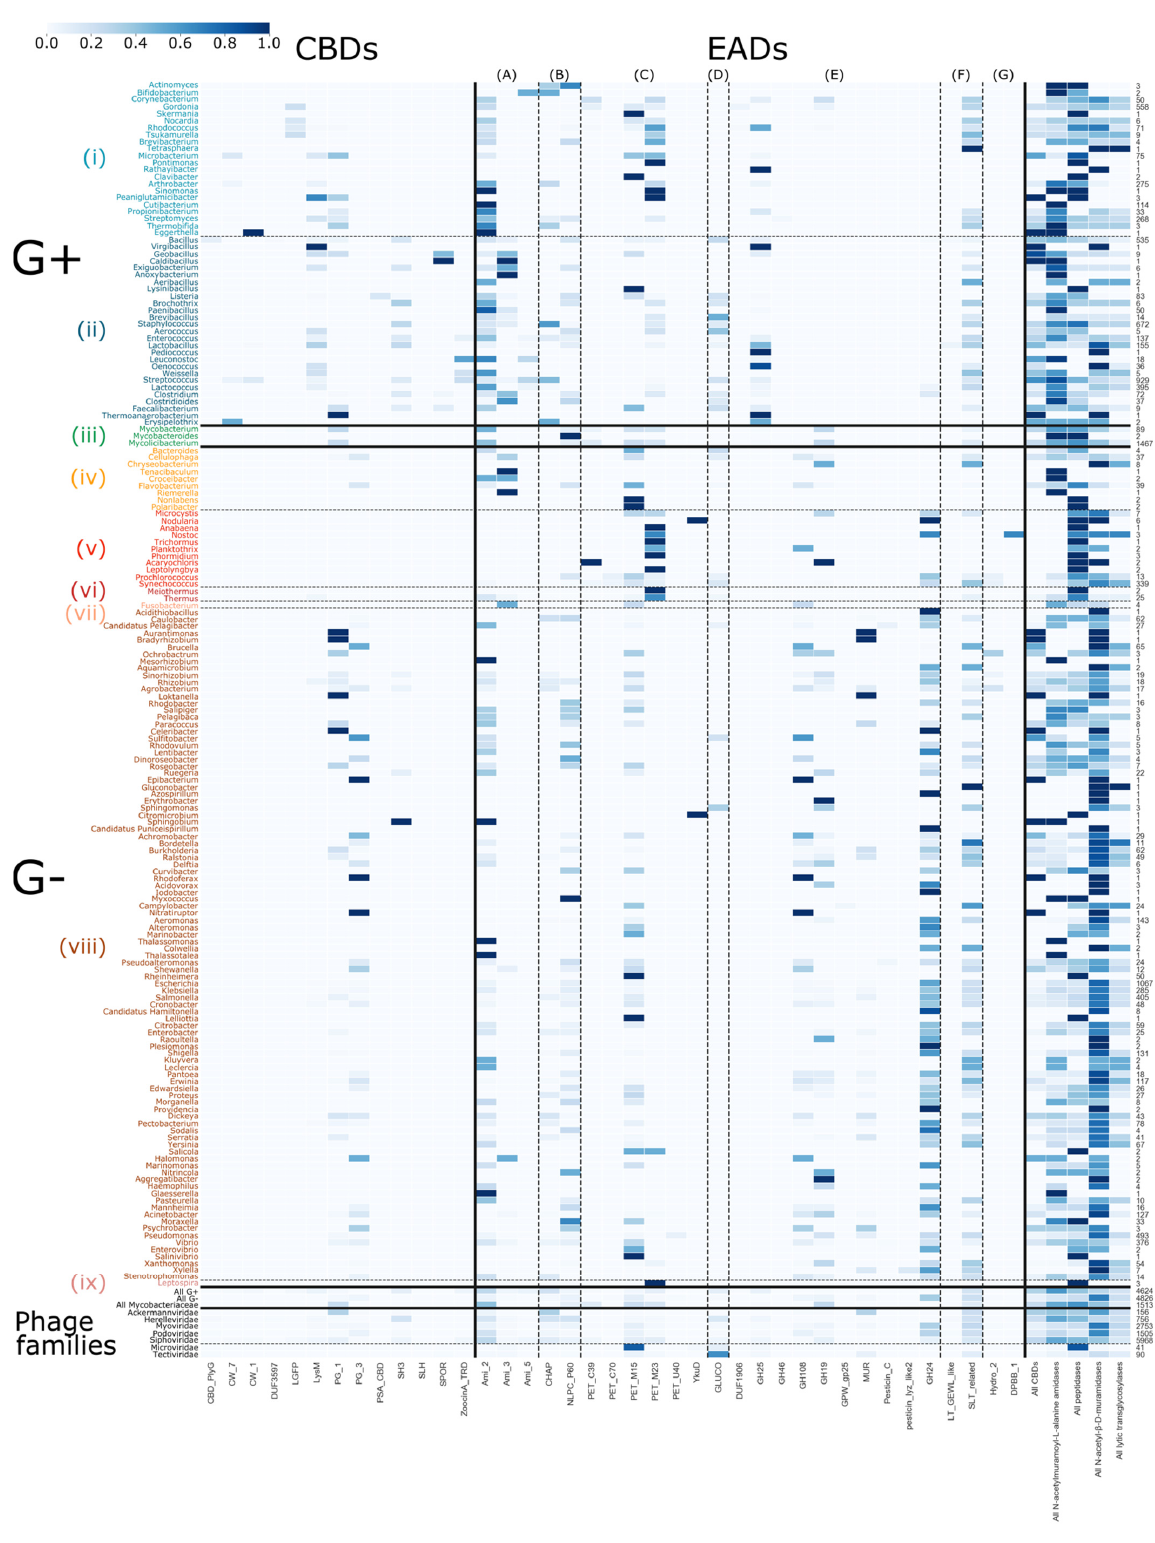
Figure 4. Distribution of EADs and CBDs across bacterial genera. The color bar on the right denotes the probability that a domain occurs in a phage lytic protein, given its bacterial host (dark blue = 1; white = 0). The examined host phyla from top to bottom, separated by dashed and full lines, are: (i) Actinobacteria without Mycobacteriaceae (family), (ii) Firmicutes, (iii) My- cobacteriaceae (family), (iv) Bacteroidetes, (v) Cyanobacteria, (vi) Deinococcus-Thermus, (vii) Fusobacteria, (viii)